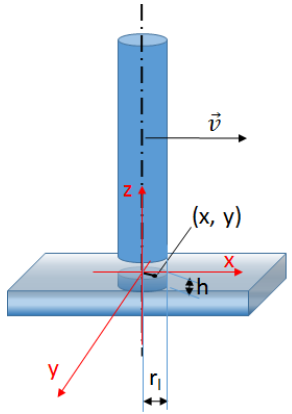
Figure 1. Scheme showing the ideal cylindrical volume inside which the laser energy source is applied, moving with the laser beam at velocity v.